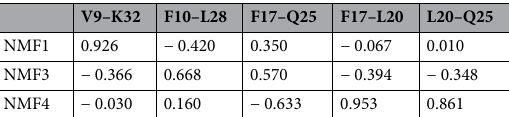
Table 1. Correlation between NMF1, NMF3 and NMF4 scores and weights on edges.